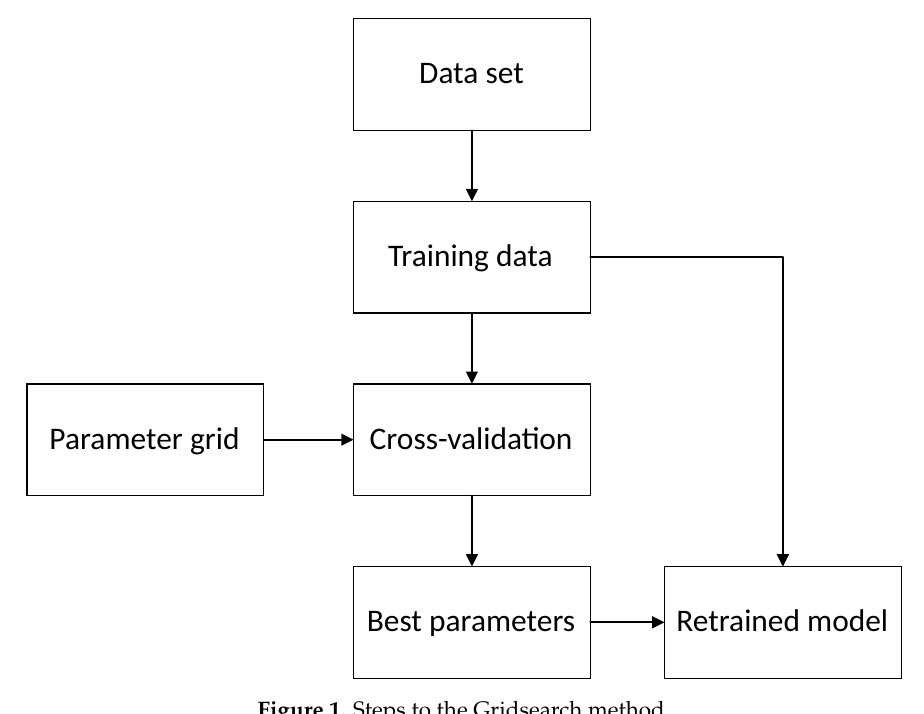
Figure 1. Steps to the Gridsearch method.